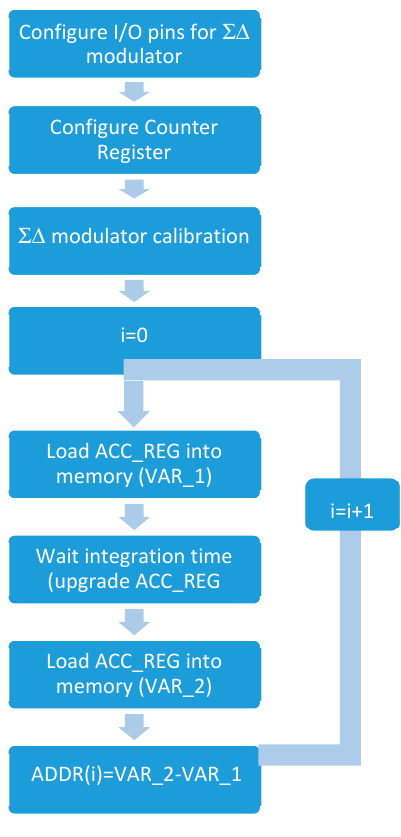
Figure 13. Σ∆ -ADC control